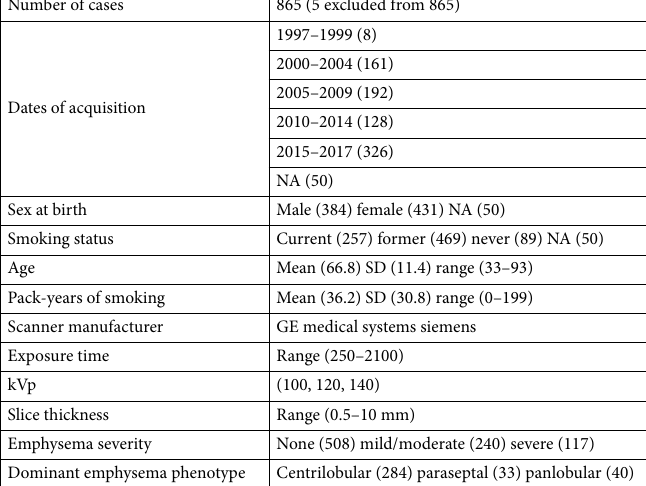
Table 1. Database